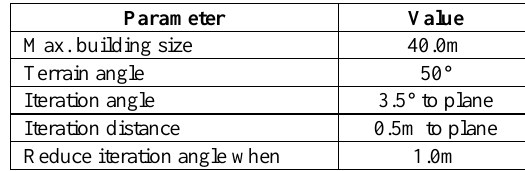
Table 1. Selected parameters for the filtering process using Adaptive TIN method